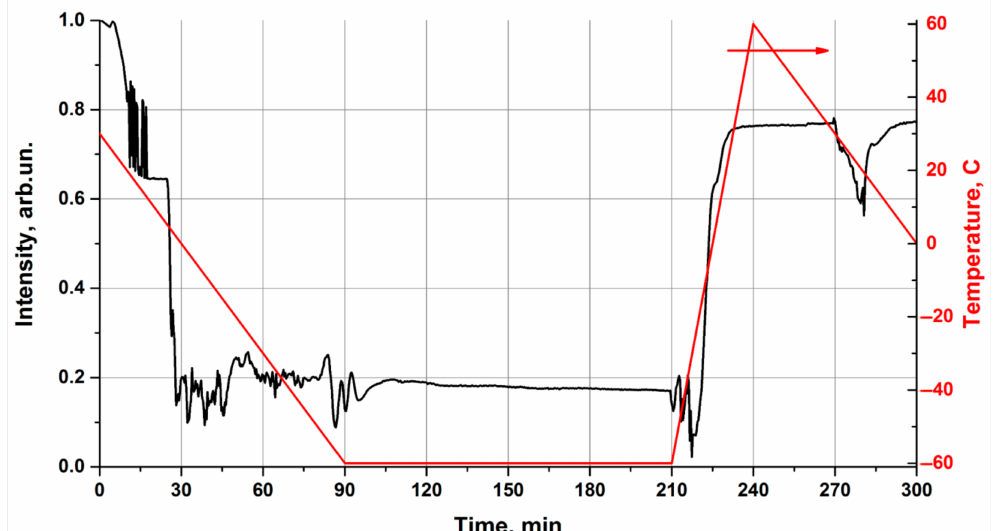
Figure 6. Temporal dependence of the normalized optical losses at wavelength of 1530 nm at different temperatures.